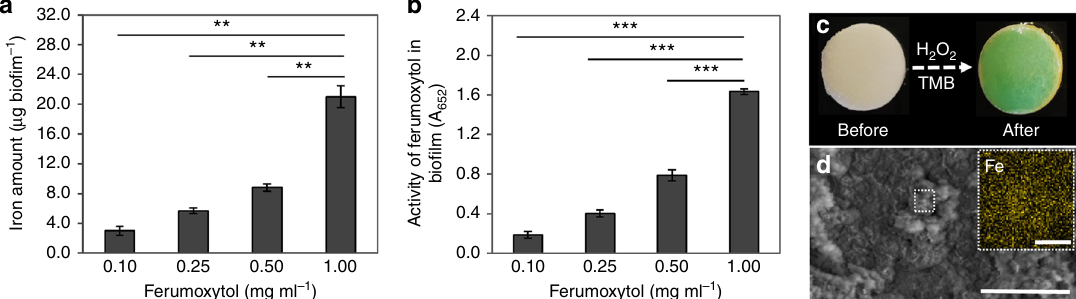
Fig. 3 Ferumoxytol binding to the bio fi lm and in situ catalytic activity. a Amount of ferumoxytol bound and b catalytic activity within bio fi lms. c Photographic images of ferumoxytol treated bio fi lm before and after exposure to H 2 O 2 in the presence of TMB (the blue color indicates free-radical generation via H 2 O 2 catalysis in situ). d SEM image of ferumoxytol treated bio fi lm (Scale bar: 200 µ m) and EDS-mapping image showing iron ions (yellow) distribution on selected area (Scale bar: 10 µ m). The data are presented as the mean ± s.d. from three independent experiments ( n = 6). The quantitative data were subjected to Student ’ s t test for a pairwise comparison. ** P < 0.01, *** P <